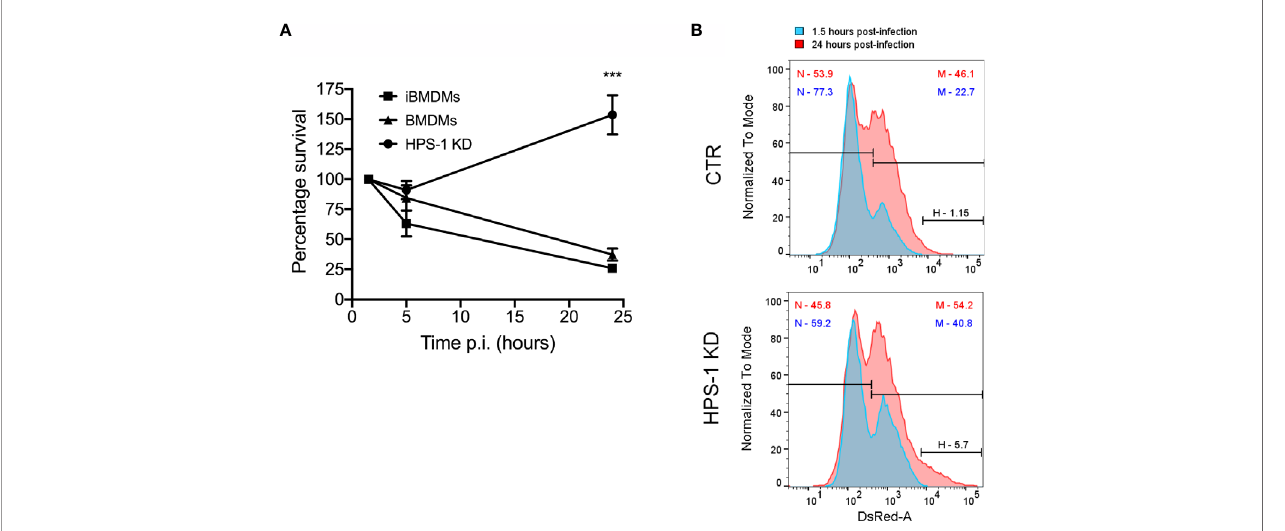
FIGURE 3 | Depletion of HPS-1 allows S . Typhi to survive better in immortalized bone-marrow-derived macrophages (iBMDMs). (A) BMDMs, iBMDMs or iBMDMs HPS-1 knockdown (HPS-1 KD) were infected with S . Typhi wild-type (MOI 5). At the indicated times post-infection, cells were lysed and CFU enumerated. The CFUs obtained are normalized against the fi rst time point 1.5 hpi, which is considered as 100% of uptake. Values are means ± SEM of two independent experiments performed in triplicates. P values were determined by the Student´s t test: ***, P < 0.005. (B) iBMDMs transduced with lentivirus encoding either non-targeting sequences (CTR) or an shRNA targeting HPS-1 (HPS-1 KD) were infected with S . Typhi:: mCherry . At different times post-infection (1.5 or 24 hpi) cells were fi xed and analyzed by fl ow cytometry. The abundance in percentage of the different subpopulations is indicated.